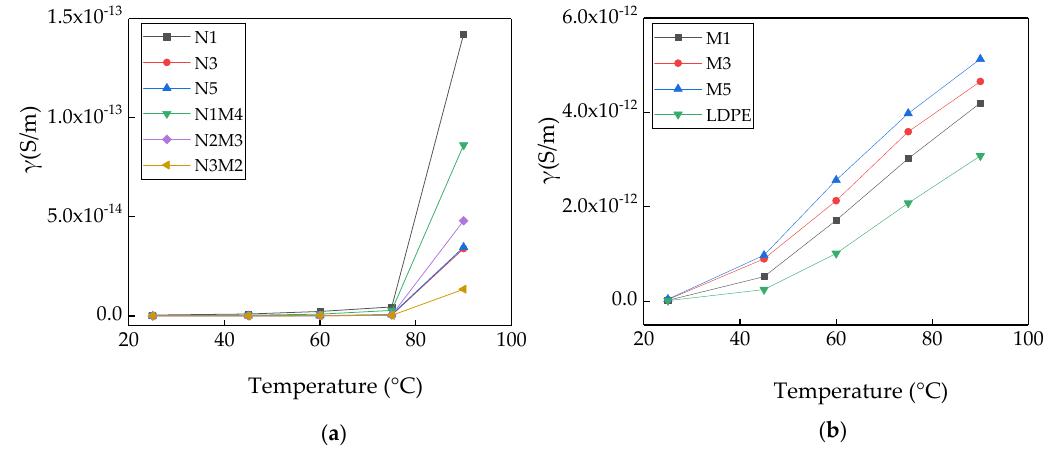
Figure 6. Variation in the conductivity of samples with the temperature: ( a ) Nano ZnO/LDPE and micro-nano-ZnO/LDPE samples; ( b ) LDPE and micro ZnO/LDPE samples.